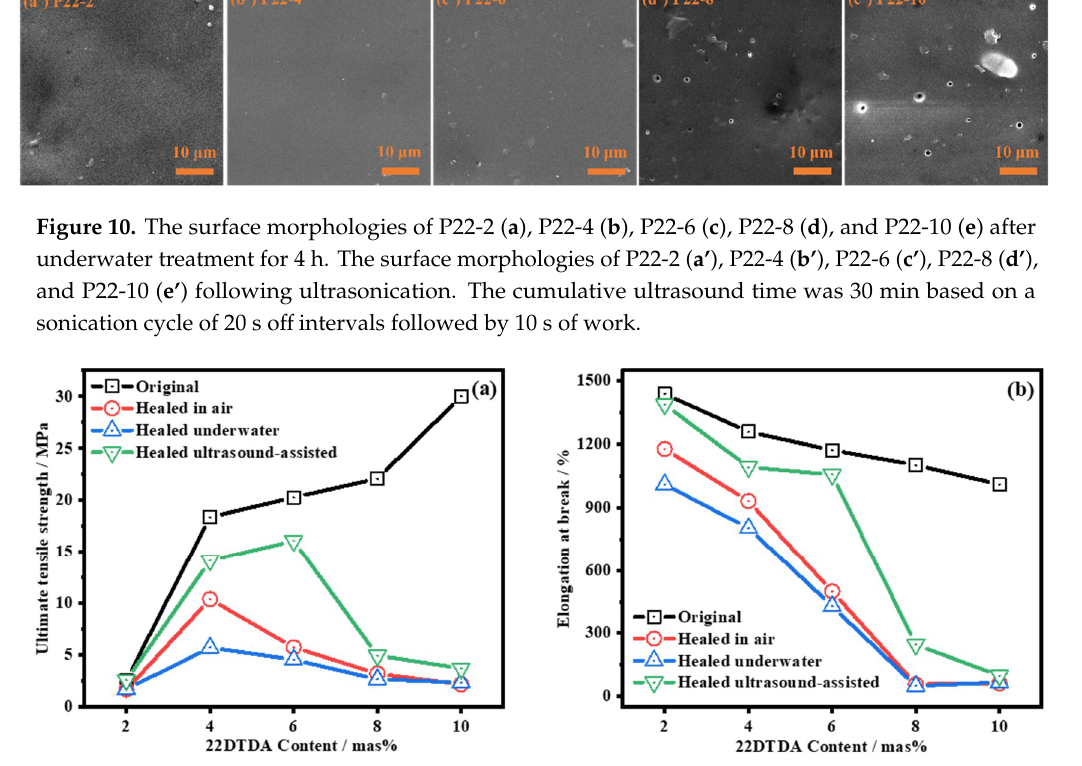
Figure 11. The ultimate tensile strength ( a ) and elongation at break ( b ) of P22 films healed at 37 °C under different conditions: in air for 4 h, in water for 4 h, and ultrasound for 30 min.